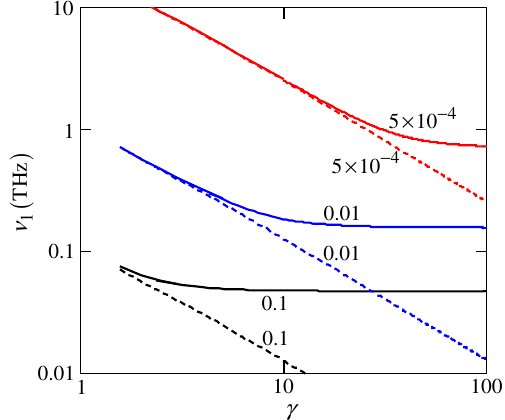
FIG. 5. Dependency of the radial electric field amplitude ð KV = m Þ at (cid:6) ¼ b (cid:1) 0 on the Lorentz factor for a ¼ E (cid:6) 1 5 mm , " ¼ 4 , j q j ¼ 1 pC , and (cid:4) ¼ 0 ; the magnitudes of d=a are given near the